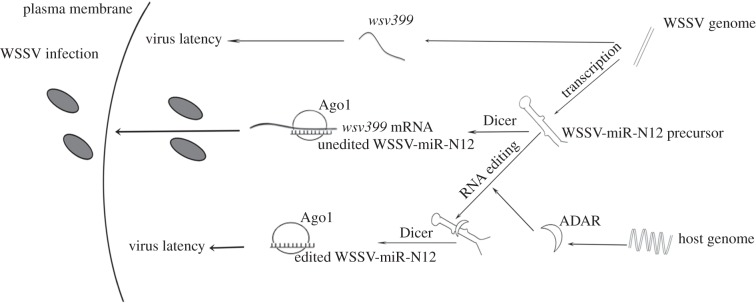
The model for the role of ADAR-mediated RNA editing of viral miRNA in virus–host interaction.